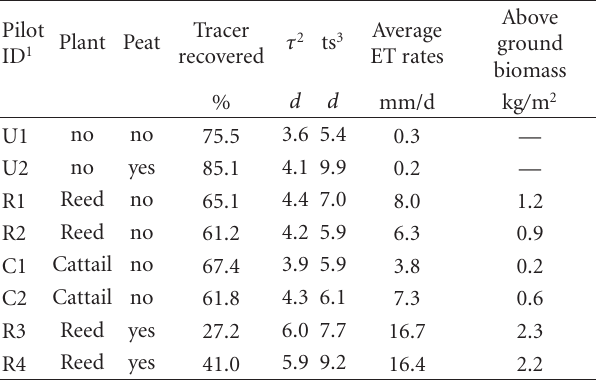
Figure 1: Section view of a mesocosm. Table 1: Description of mesocosms, pulse input tracer, evapotran- spiration, and aboveground